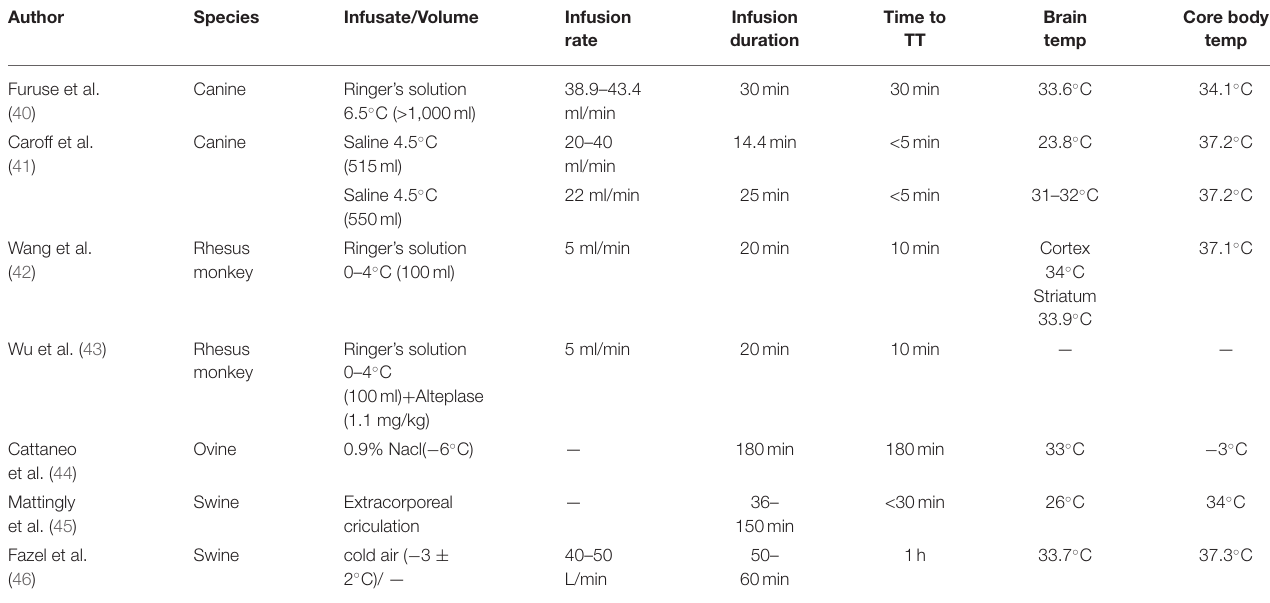
Infusion duration